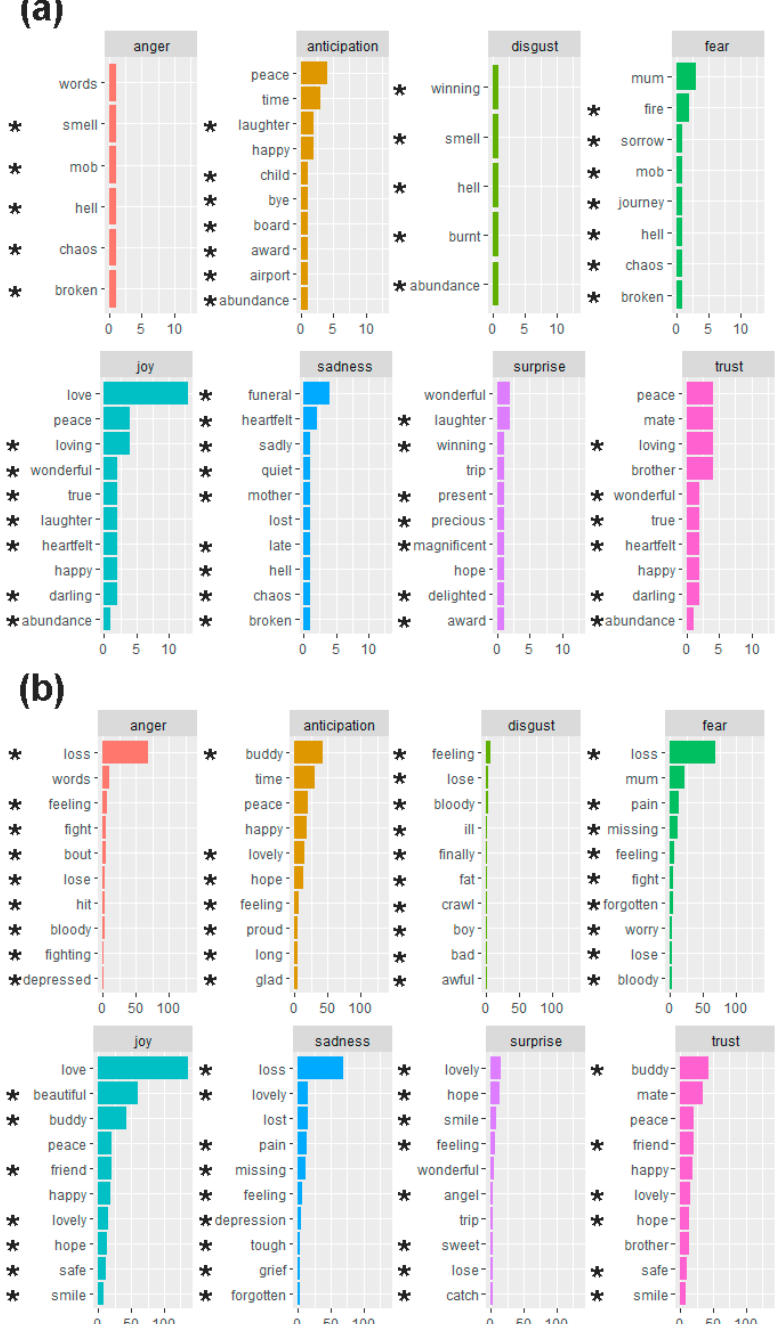
Figure 2. List of the 10 most frequent words associated with each NRC lexicon emotion in ( a ) the cluster cases and ( b ) the non-cluster controls. * Indicates the most frequent words for an emotion for this group that do not fall among the most frequent words for the same emotion in the other group. Words that are not marked with * are common in both groups. The frequency of words is denoted along the x